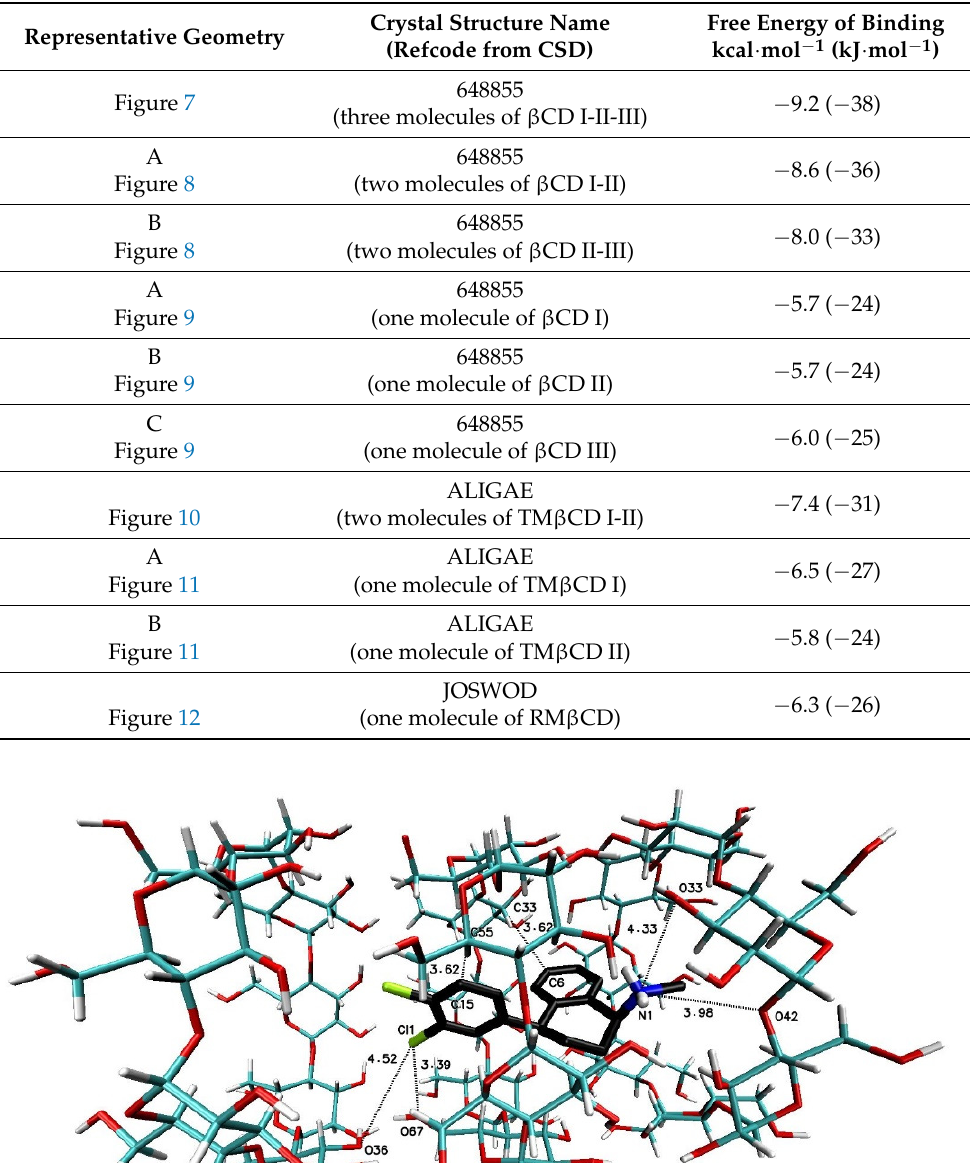
Table 3. The values of binding energies for SRT and chosen β CD molecules obtained from molecular docking results.